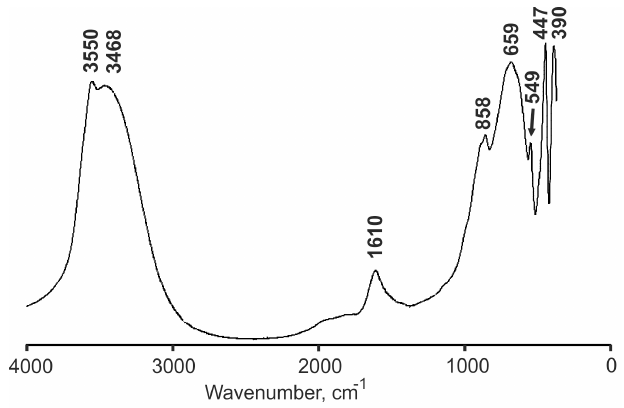
Figure 4. Infrared (IR absorption) spectrum of chlormagaluminite. Table 3. Assignment of infrared (IR) bands (cm − 1 ) of chlormagaluminite and its comparison to quintinite.